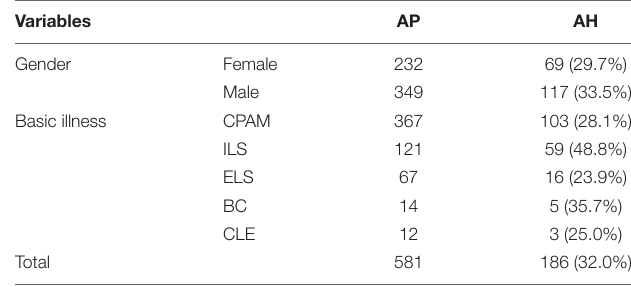
TABLE 1 | Characteristics of the study population.